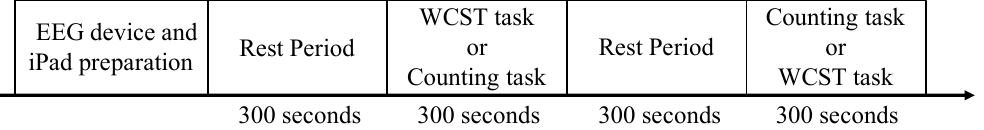
Figure 5. The practical experiment procedure, during which EEG recordings of participants were obtained throughout the simple counting task and Wisconsin Card Sorting Test (WCST)